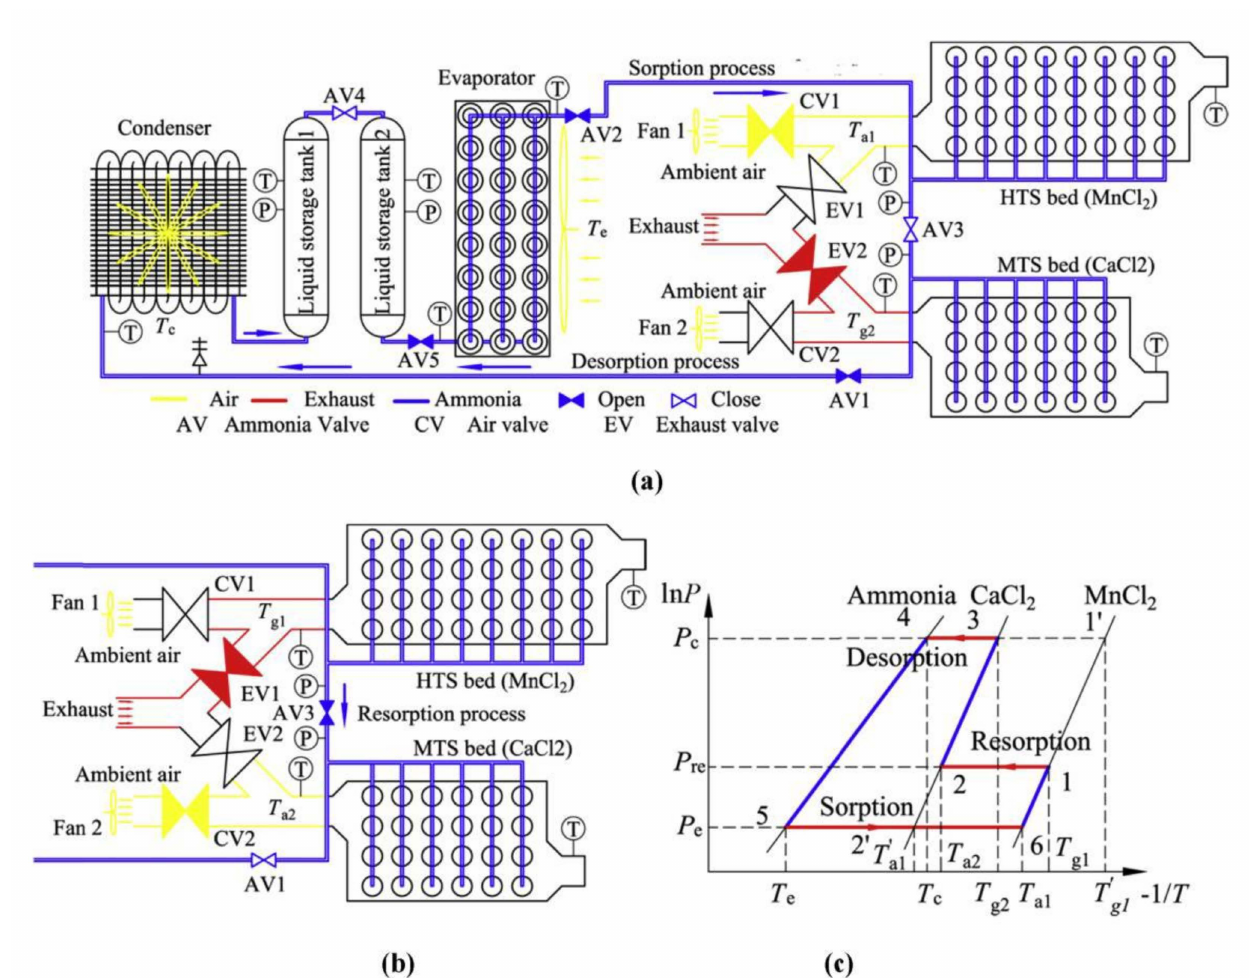
Figure 18. Two-stage solid sorption freezing system: ( a ) Sorption process of the HTS bed and desorption process of the MTS bed; ( b ) Resorption process between the HTS bed and the MTS bed; ( c ) lnP-T diagram. Reprinted from ref. [59], Copyright 2016, with permission from